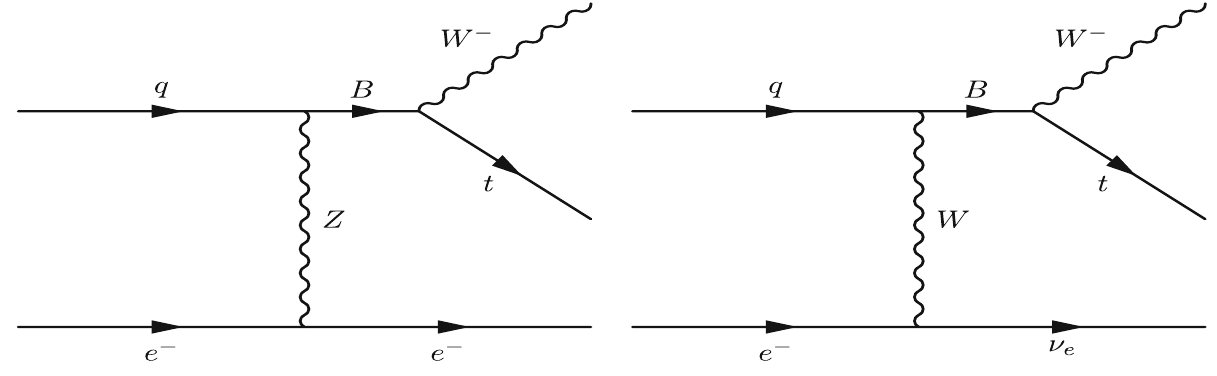
Fig. 1 The branching ratios of the decay modes Wu R